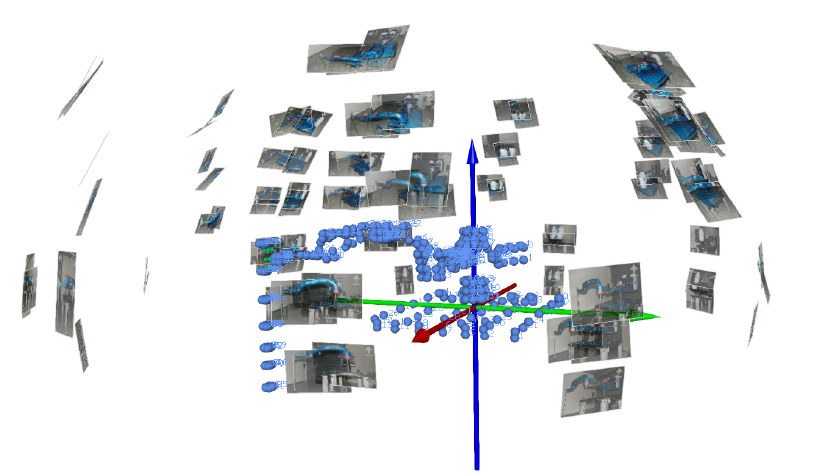
Figure 6. Camera positions when taking pictures/calculated point components of the robotic